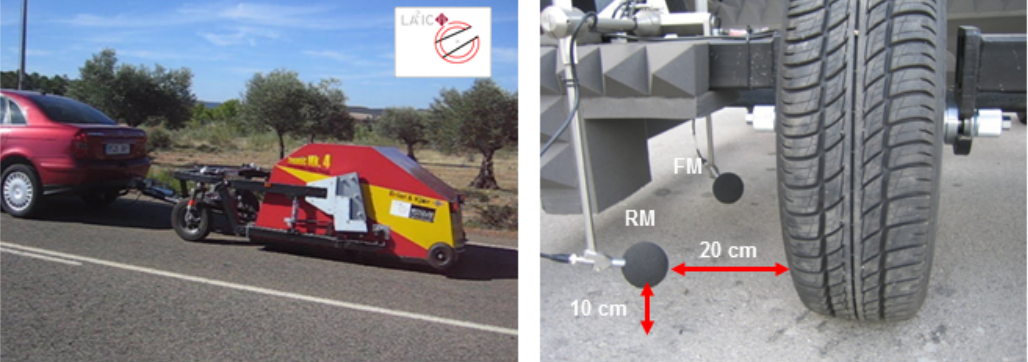
Figure 3. Tiresonic Mk4-LA 2 IC for acoustic characterization of road surfaces and detail of the microphone positions in the close proximity of a reference tire inside the semi-anechoic